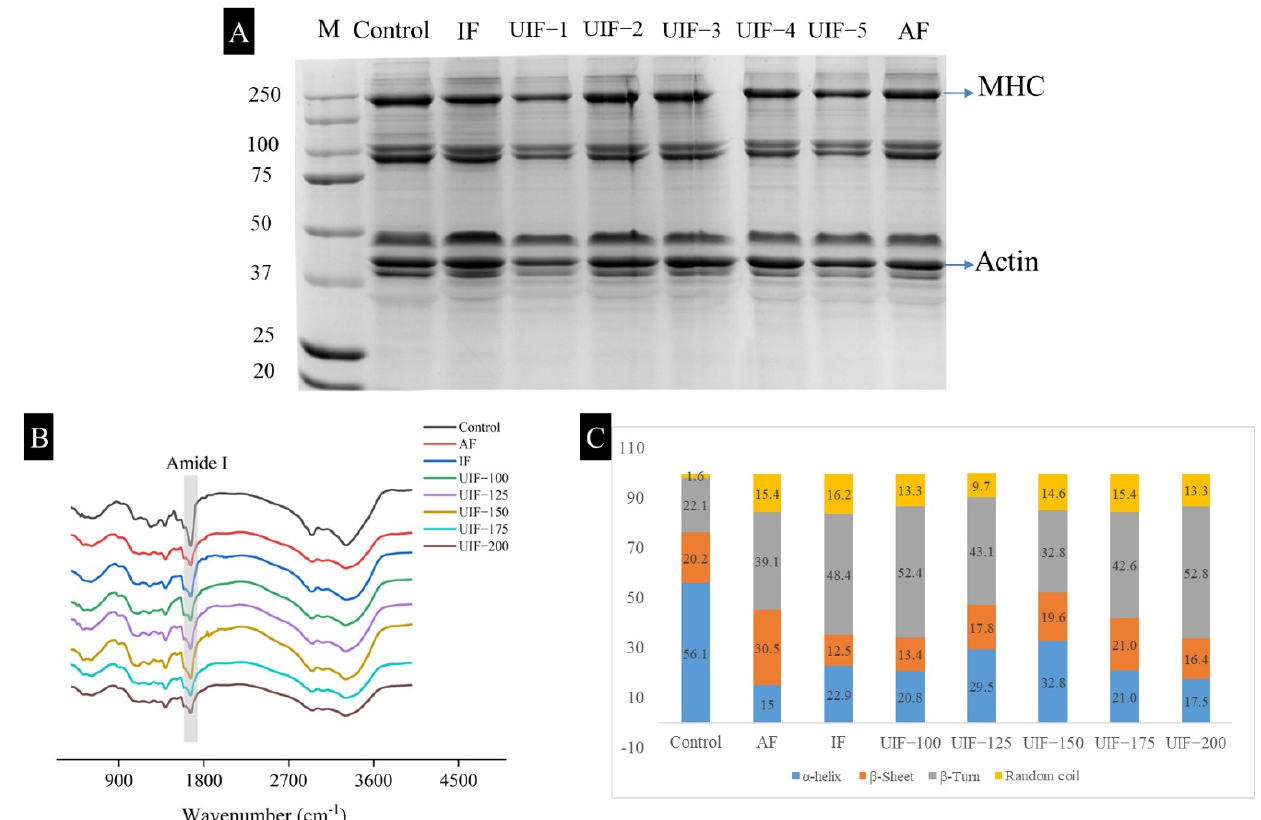
Figure 3. ( A ) SDS-PAGE pattern, ( B ) Fourier transform infrared spectra and ( C ) Secondary structure